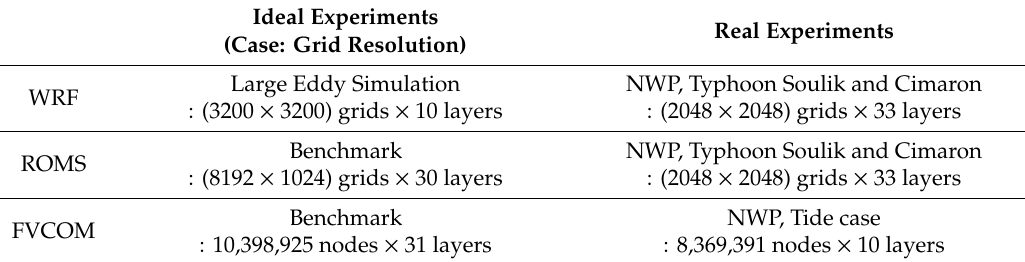
Table 2. Experimental model